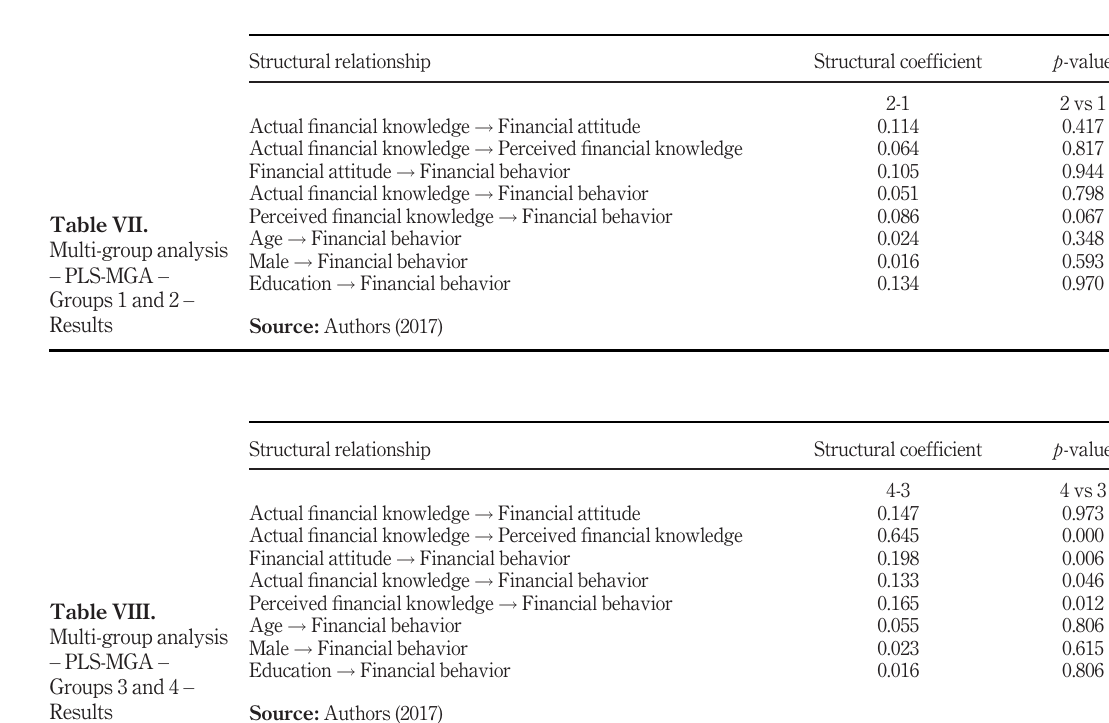
Table VIII. Multi-group